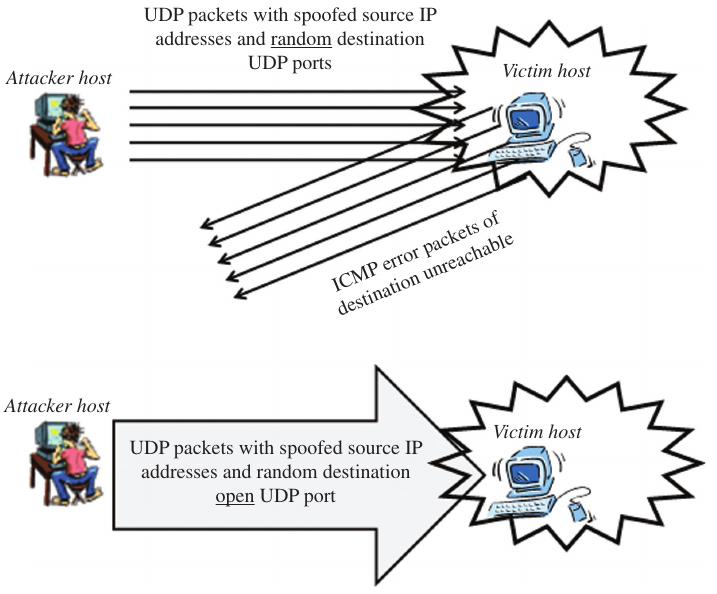
Figure 4. UDP Flood Attack.